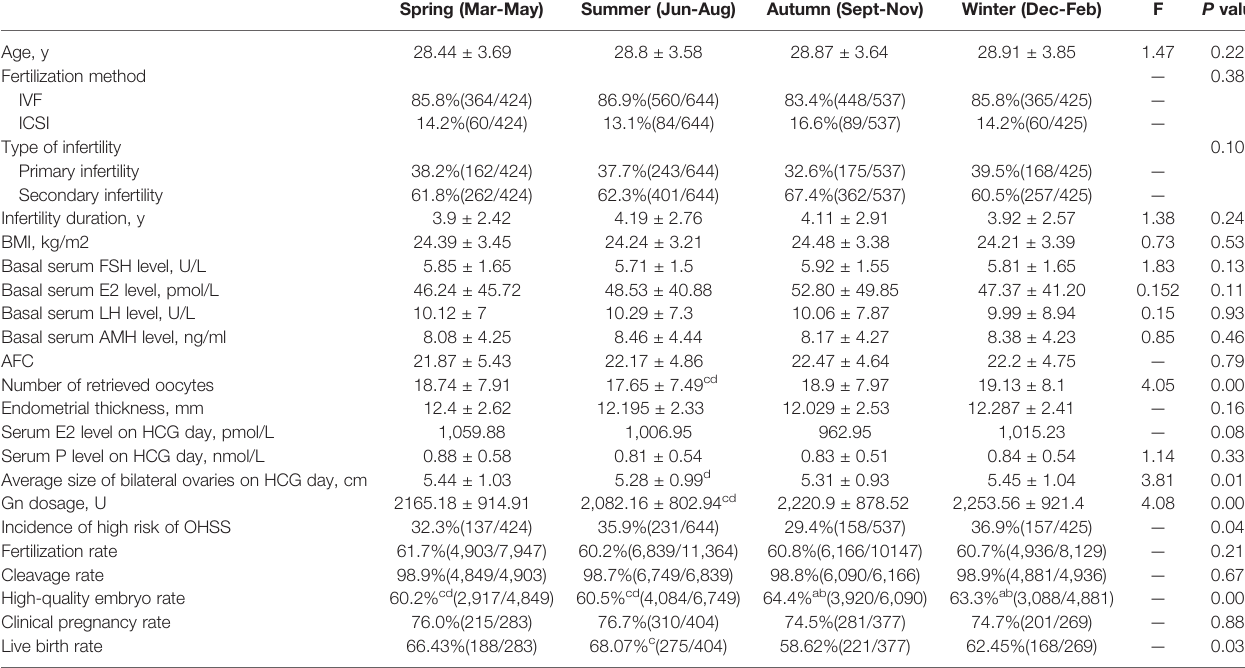
TABLE 1 | Baseline characteristics and cycle outcomes in different